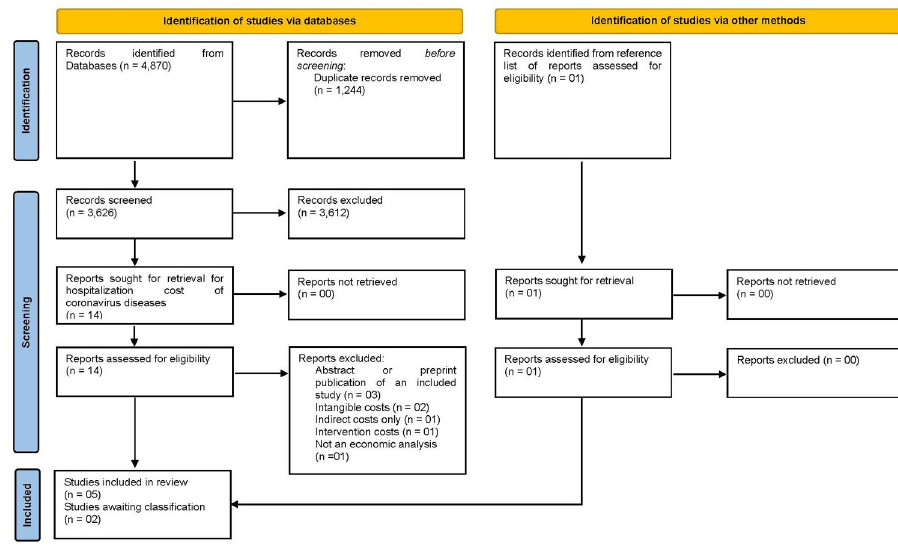
Fig 1. PRISMA flow diagram. Adapted from Page et al . (2021)